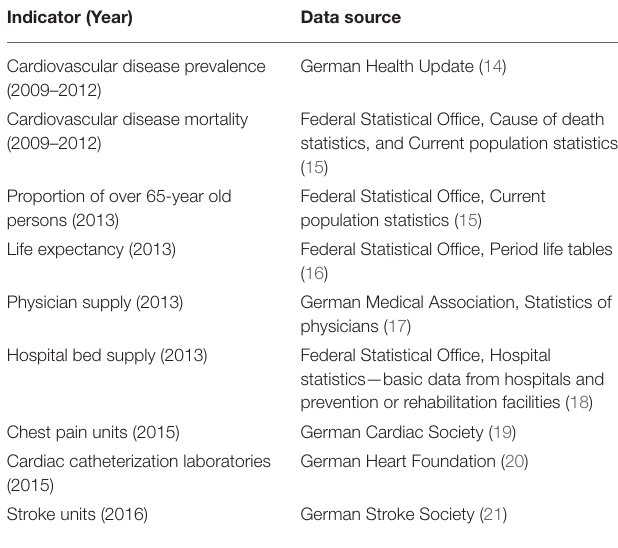
TABLE 1 | Data sources of health and health care supply